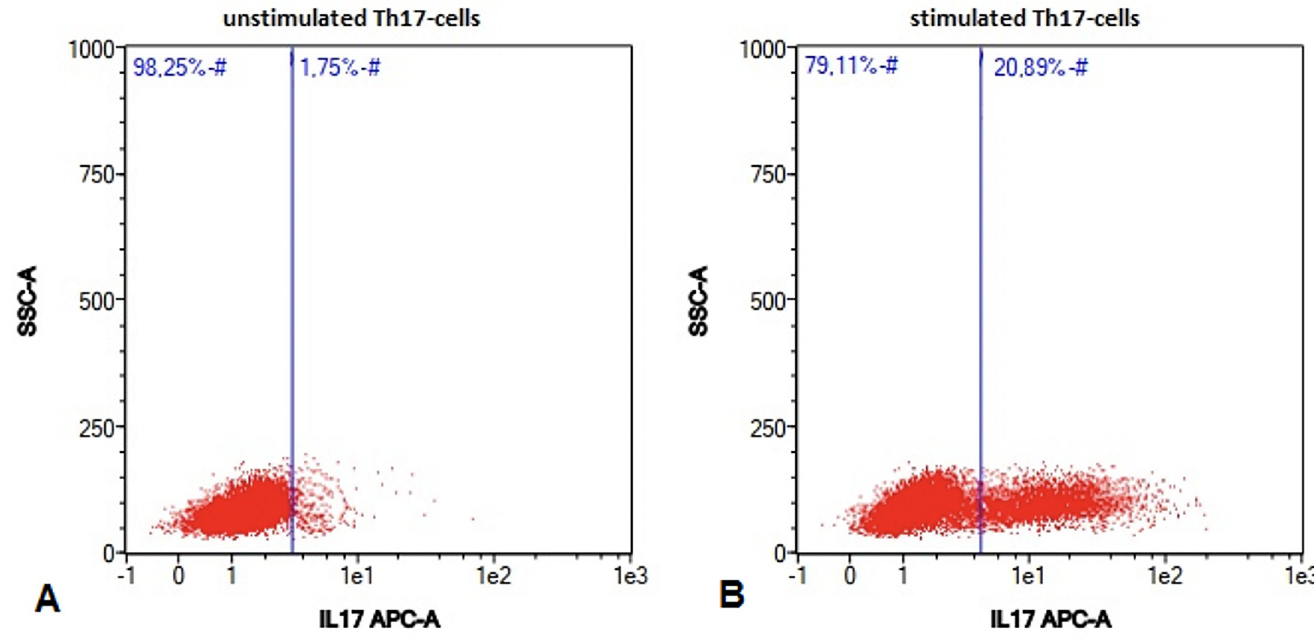
Fig 1. Stimulation of Th17-cells. Example of unstimulated Th17-cells (A) and stimulated Th17-cells (B) in canine peripheral blood sample of a dog suffering from intervertebral disc herniation measured by using flow cytometry. The stimulation of the Th17-cells was performed by using a specific lymphocyte medium including PMA (Phorbol-12-myristat-13-acetat) and Ionomycin calcium salt. Due to stimulation, it was possible to detect significant differences between the samples. IL17: Interleukin 17; Th17-cells: T-helper 17 cells; SSC: Sidewards Scatter; APC: Allophycocyanin.